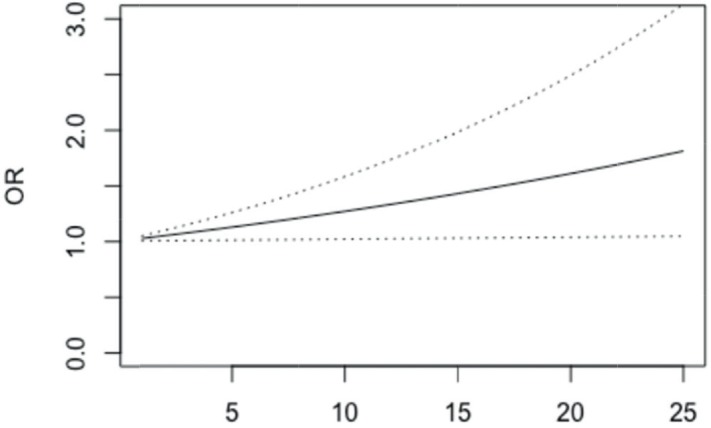
OR of not having depression in patients with differences in BRFU scale scores between 1 and 25 points (95% confidence bands for the OR are shown in dash lines).